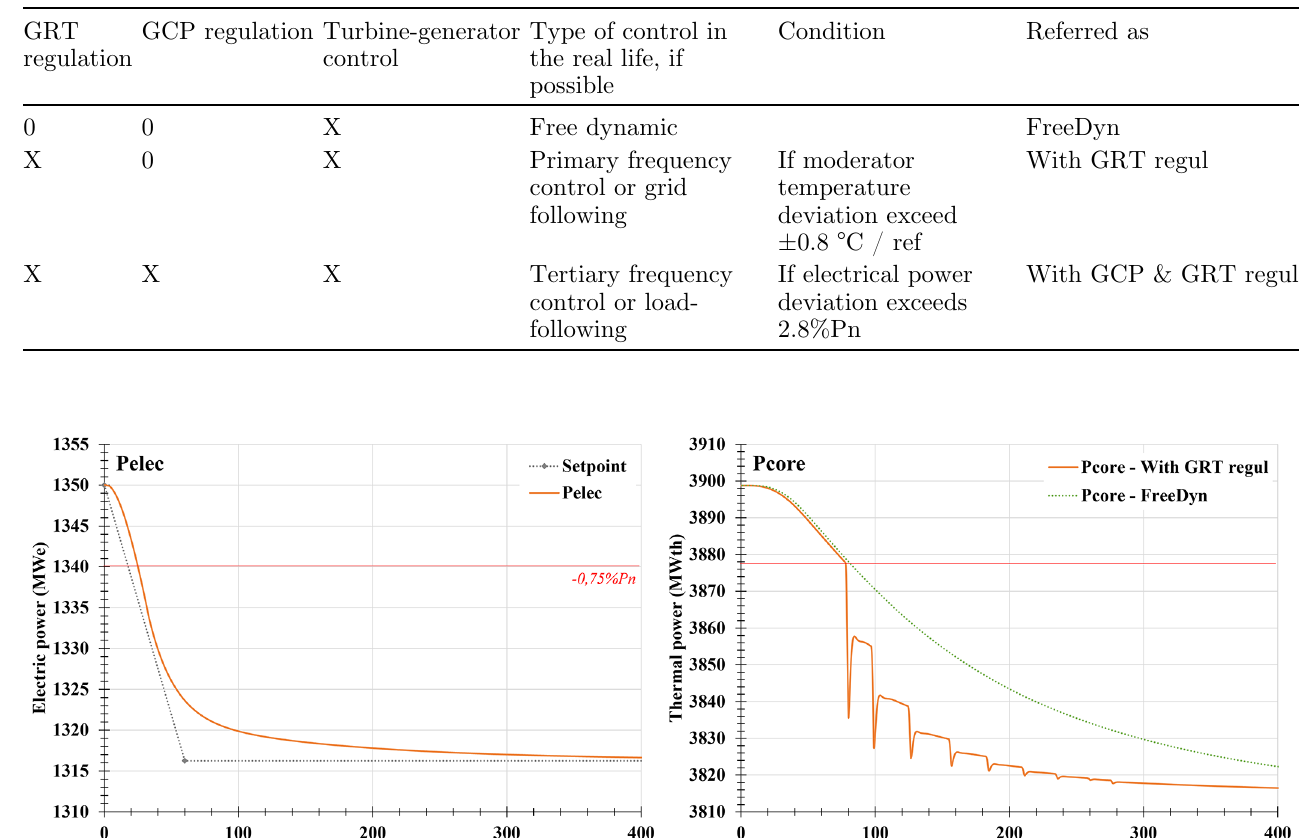
Table 1. Nomenclature of the study.